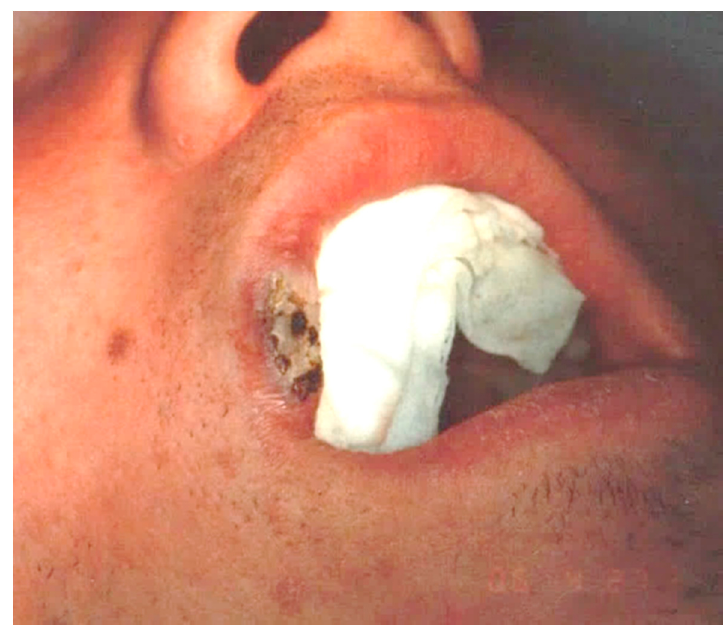
Figure 5. Vaporization of the lesion in defocused mode using the CO 2 laser.